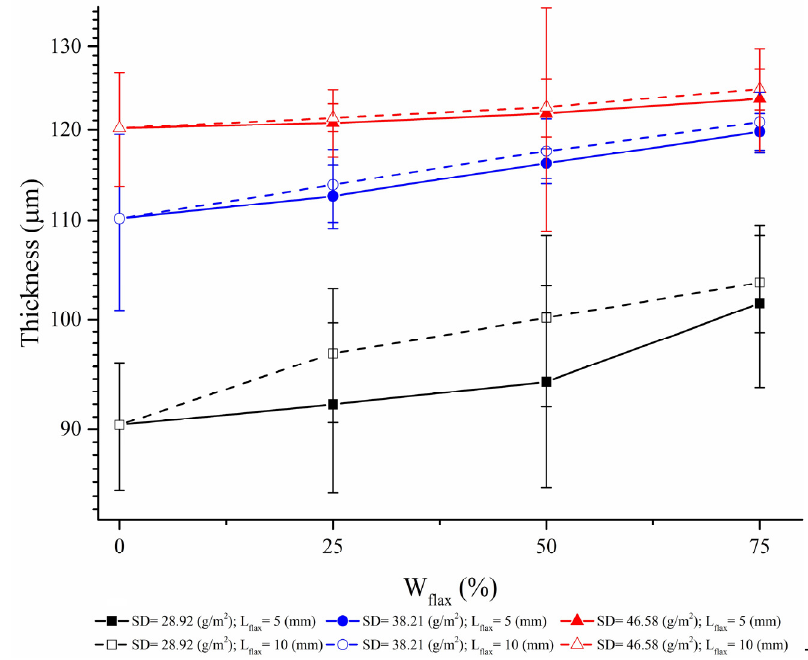
Figure 6. Effect of short flax fiber content on paper layer thickness.